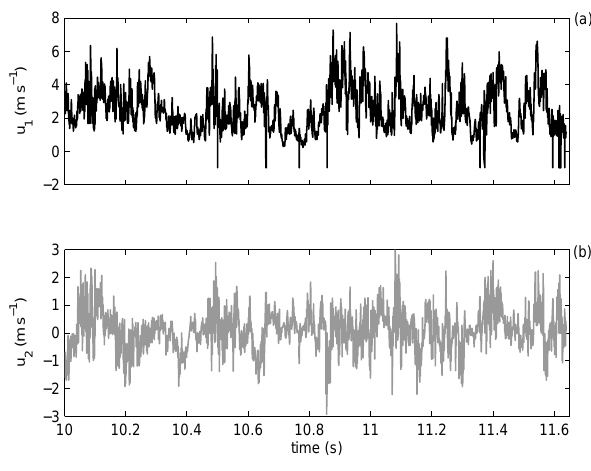
Fig. 1. Two perpendicular components of turbulent velocity data ( u 1 in black and u 2 in grey) obtained in a wind tunnel at